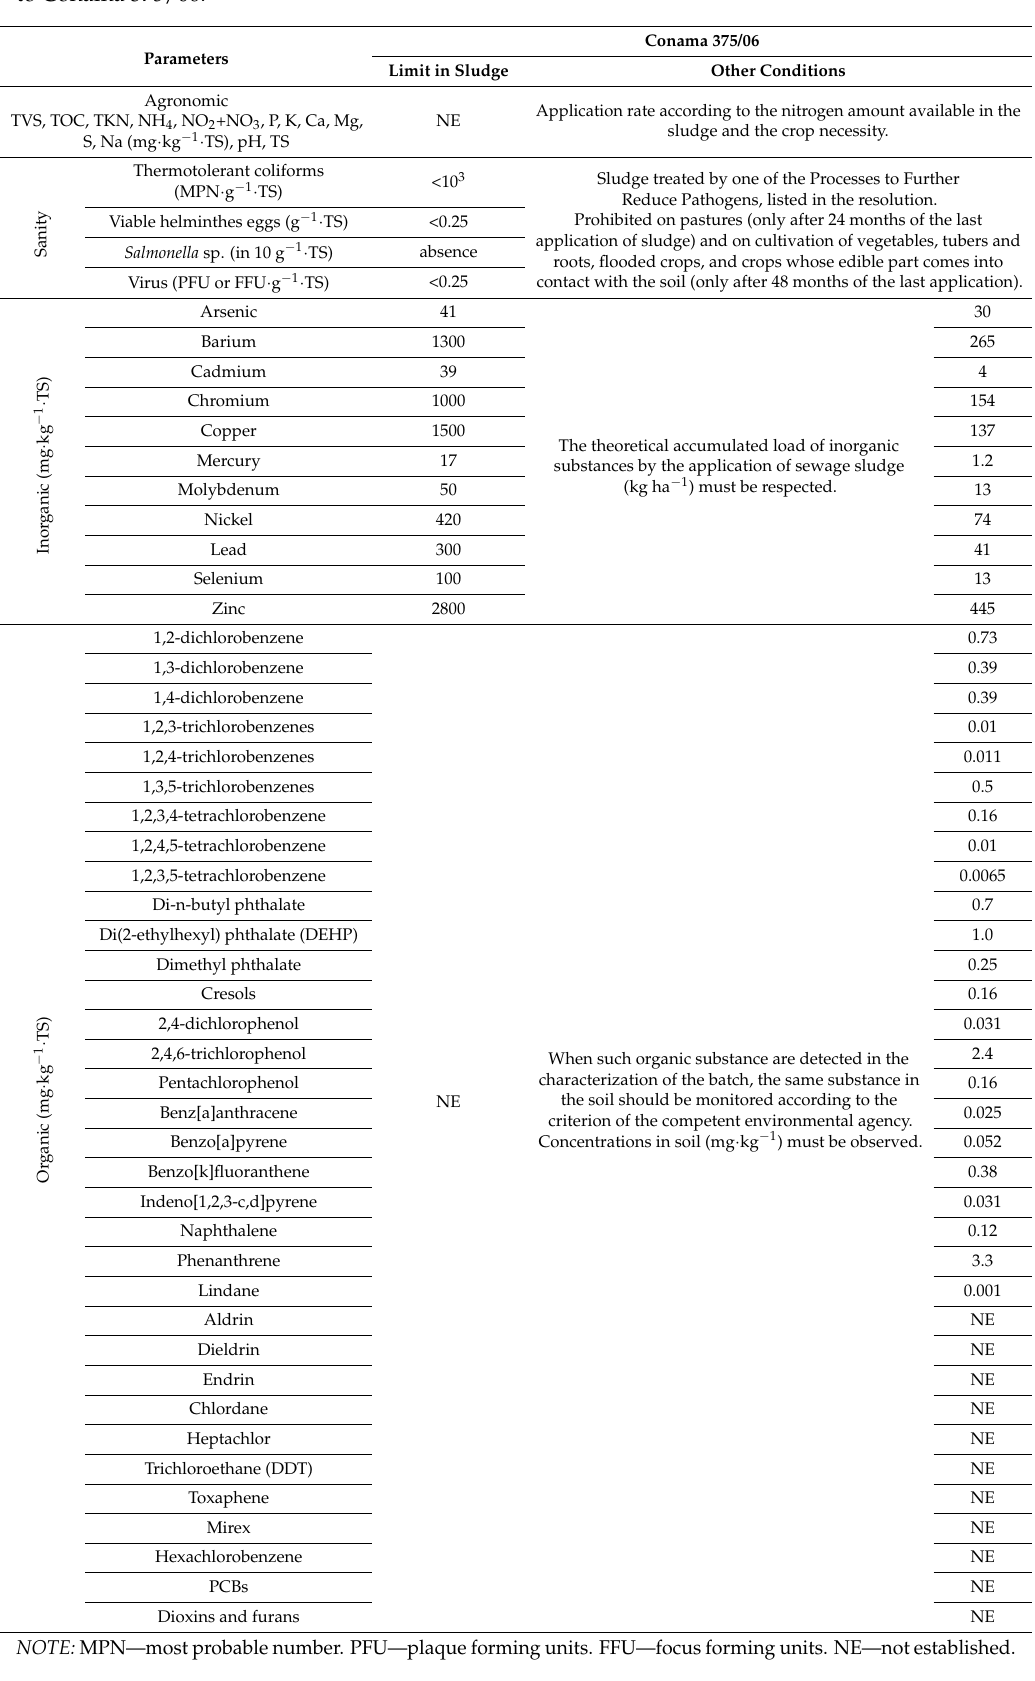
NOTE: MPN—most probable number. PFU—plaque forming units. FFU—focus forming units. NE—not